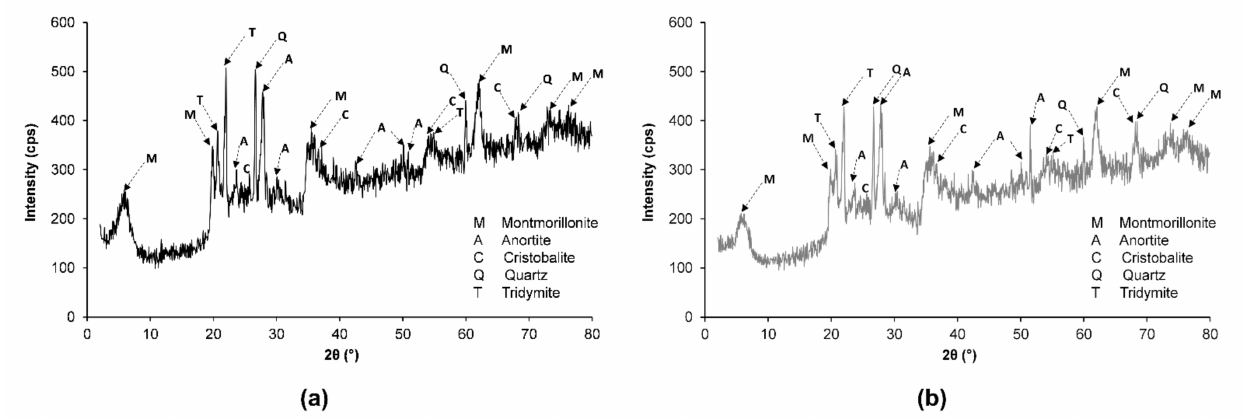
Figure 6. X-ray diffractogram of: ( a ) natural and ( b ) diesel-contaminated soils. The presence of quartz, cristobalite, and tridymite was also observed. Silica or silicon dioxide (SiO 2 ) can exhibit both crystalline (quartz, tridymite, and cristobalite) and amor- phous forms. Cristobalite and tridymite are silica mineral quartz polymorphs that exhibit the same chemical formula but have different crystal